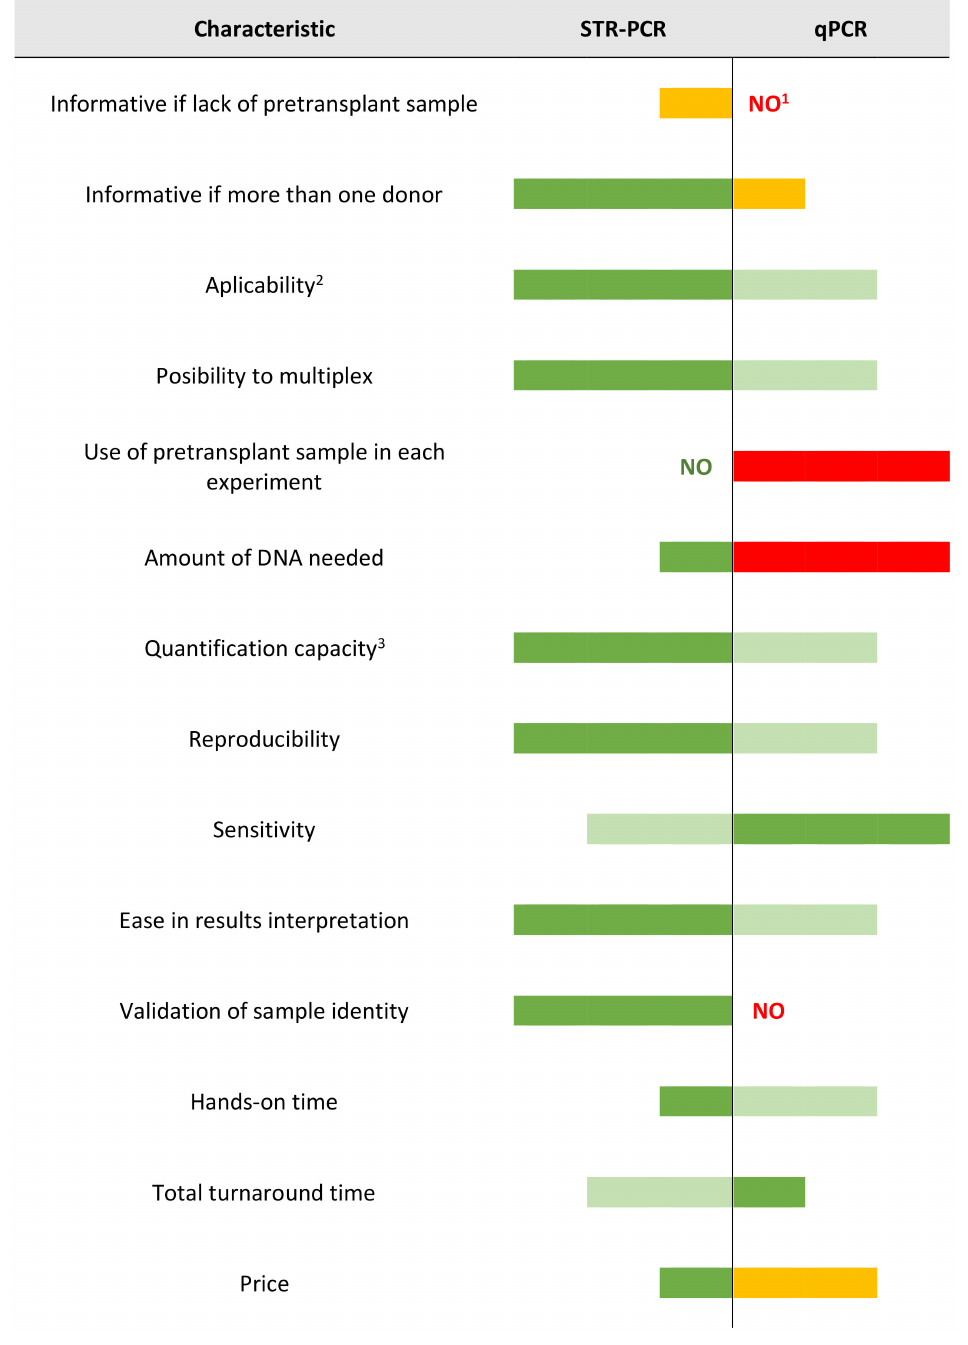
Figure 5. Comparison of technical characteristics of STR-PCR and qPCR. 1 Possible if monitoring for SRY gene in sex-mismatched donor / recipient pairs, by using any male donor as a positive control. 2 Percentage of informative loci per screened loci. 3 Especially with high percentage of expected minor allele. Colors in graph state for qualitative evaluation of each characteristic: very good (dark green), good (light green), bad (yellow), very bad (red). Length of bars state for quantitative evaluation of each characteristic (high, medium, low,